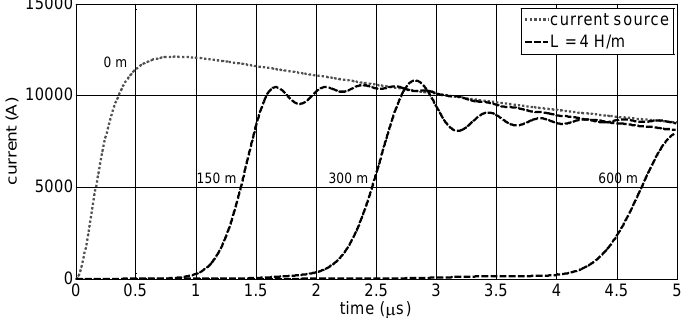
Figure 8. Current distribution along the lightning channel at different height calculated by CST-MWS for L = 4 μH/m and R = 1 Ω/m for channel length = 0–500 m, R = 6 Ω/m for channel length = 500–2000 m. Model C : Wire in free-space loaded by distributed series inductance.